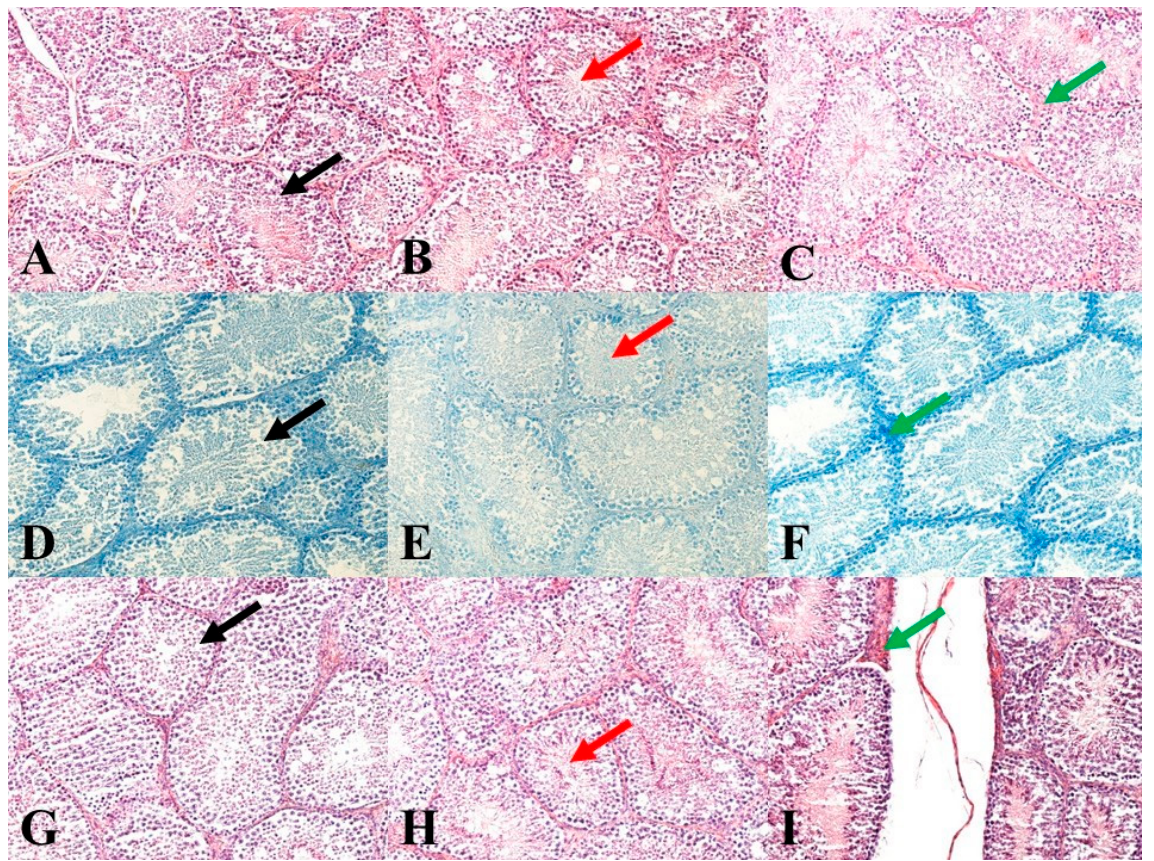
Figure 1. Representative images of testicular histology. ( A ): Control group. HE: 200×. ( B ): E1 group. HE: 200×. ( C ): E2 group. HE: 200×. ( D ): Control group. Toluidine Blue Polychromatic: 200×. ( E ): E1 group. Toluidine Blue Polychromatic: 200×. ( F ): E2 group. Toluidine Blue Polychromatic: 200×. ( G ): Control group. Sirius red: 200×. ( H ): E1 group. Sirius red: 200×. ( I ): E2 group. Sirius red: 200×. Black arrows show seminiferous tubules and germ cells in various stages of development. Red arrows show mature sperm in seminiferous tubules. Green arrows show septa between seminiferous tubules.